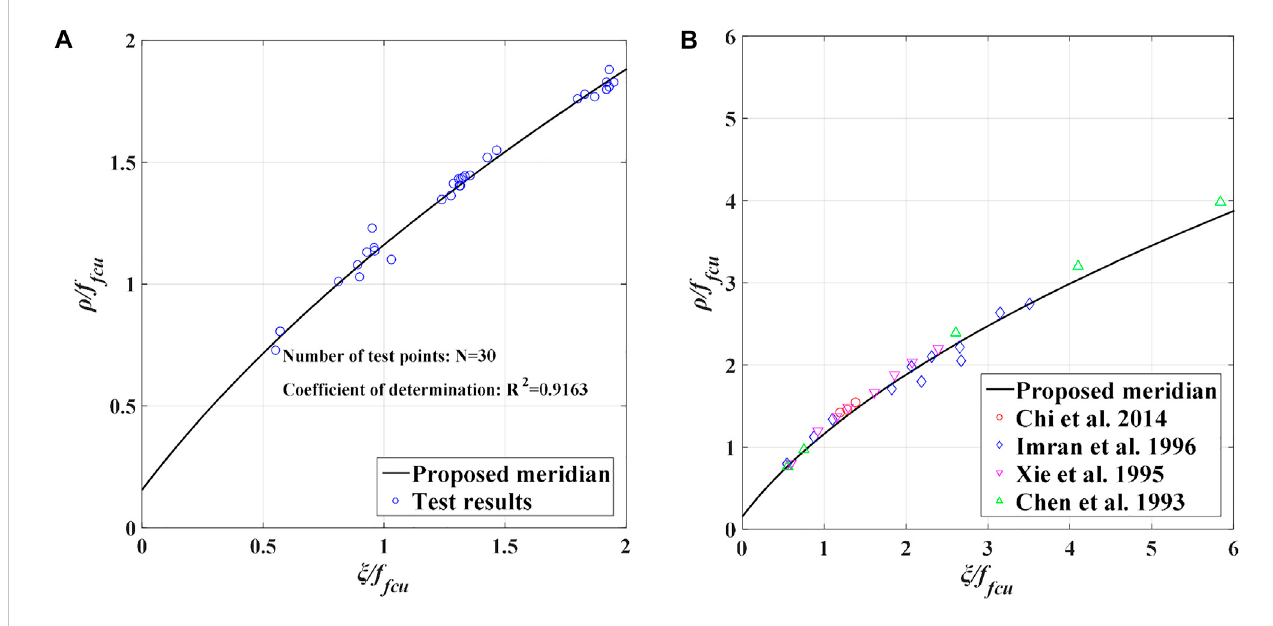
FIGURE 11 Validation and application of the proposed